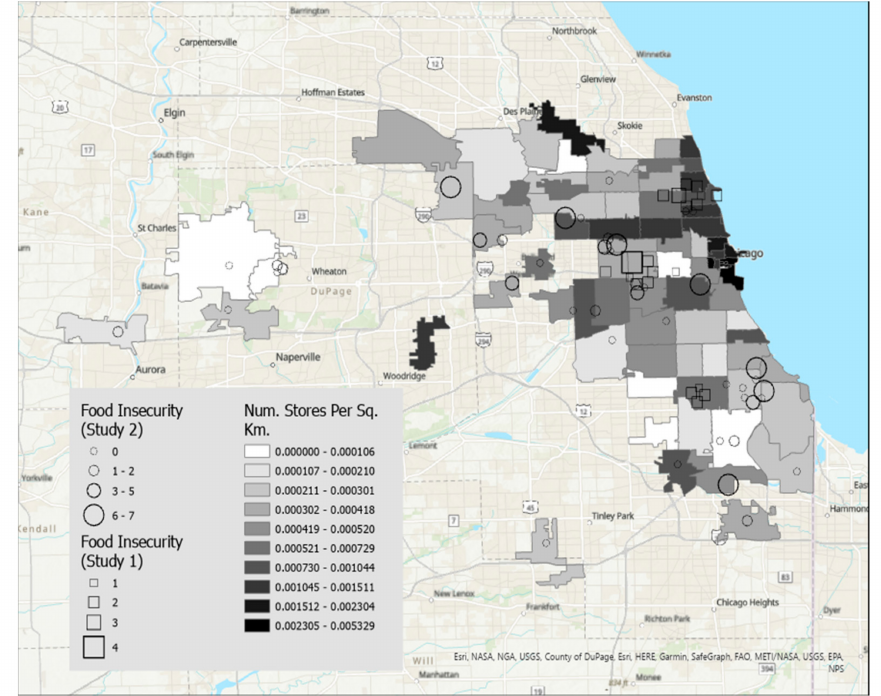
Figure 2. This figure displays food insecurity overlaid on a map of store density (darker shade indicates higher density). There did not appear to be clear a relationship between food insecurity and store density.